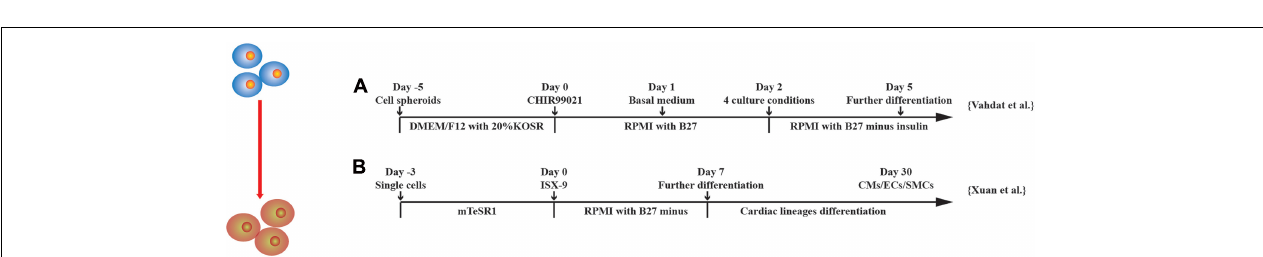
FIGURE 4 | Schematic diagram of differentiation of hPSCs into smooth muscle cells. (A,B) Schematic diagram of chemically defined protocols. GSK3 inhibition or BMP4 treatment followed by activin-A and PDGF-BB treatment induced VSMCs from hPSCs, and subsequent applications of PDGF-BB or heparin with activin-A obtained synthetic or contractile VSMCs, respectively. (C) Schematic diagram of EB protocol for differentiation of VSMCs from hPSCs. (D,E) Schematic diagram of chemically defined protocols that efficiently induced hPSCs to differentiate into VSMCs with different phenotypes. Both methods first used GSK3 inhibition and BMP4 to stimulate differentiation into mesoderm cells and then treated with VEGF-A and FGF β . Synthetic VSMCs (D) were produced by culturing the cells with VEGF-A and FGF β and with PDGF- β and TGF- β in order. Contractile VSMCs (E) were induced by culturing the cells with PDGF- β and TGF- β directly.